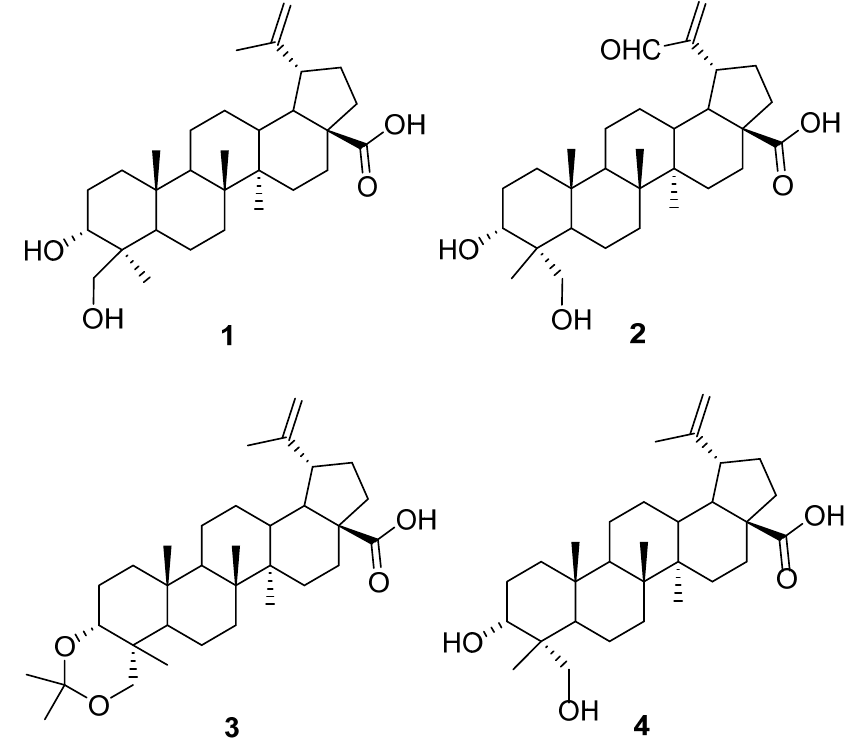
Figure 1. Chemical structures of compounds 1 – 4 .